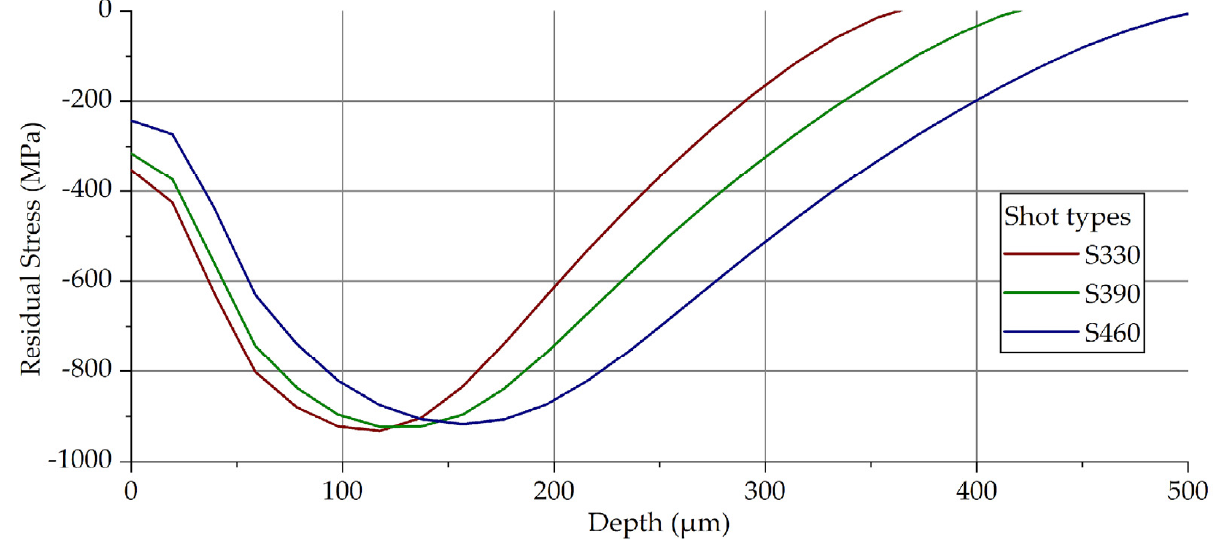
Figure 9. Averaged residual stress profiles for three different shot types.